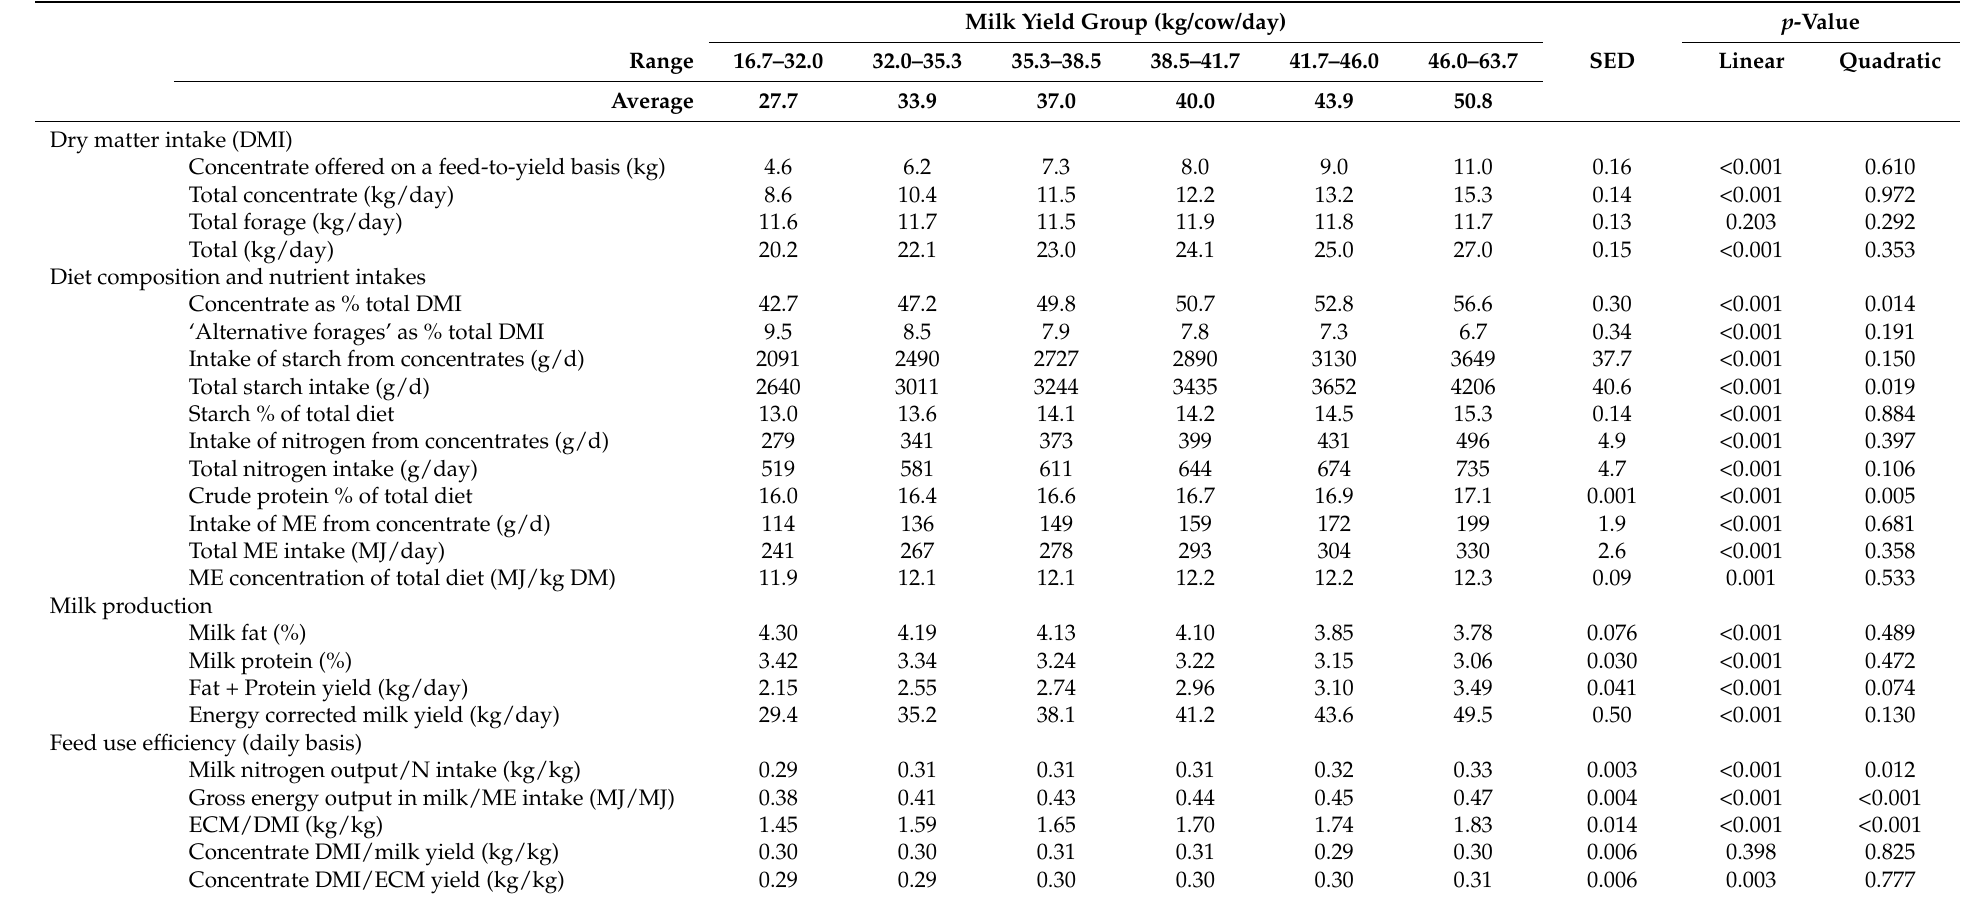
Table 4. Dry matter intakes, nutrient intakes and diet composition, milk production, and efficiency values within each milk yield group for third lactation